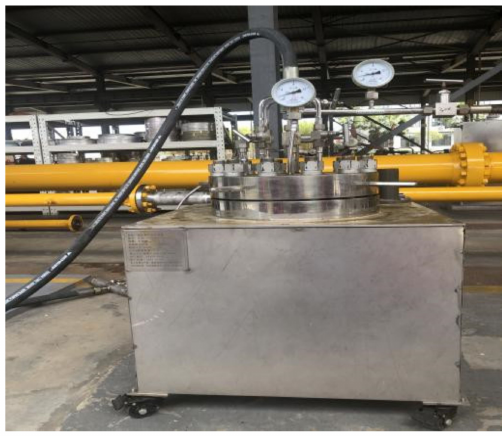
Figure 6. Particle charging device. Figure 7 contrasts the PIV flowmeter measurement results with the ultrasonic flowme- ter measurement results. The figure shows that in small flow conditions, the relative errors of the two kinds of flowmeter measurement results are small, indicating reliable measure- ment results. However, with an increase in the flow rate, the PIV flowmeter and ultrasonic flowmeter measurement results are significantly different; in the 600 m 3 /h case, the rel- ative error value reached more than 6% (relative error value = (ultrasonic measurement results—PIV measurement results)/ultrasonic measurement results).